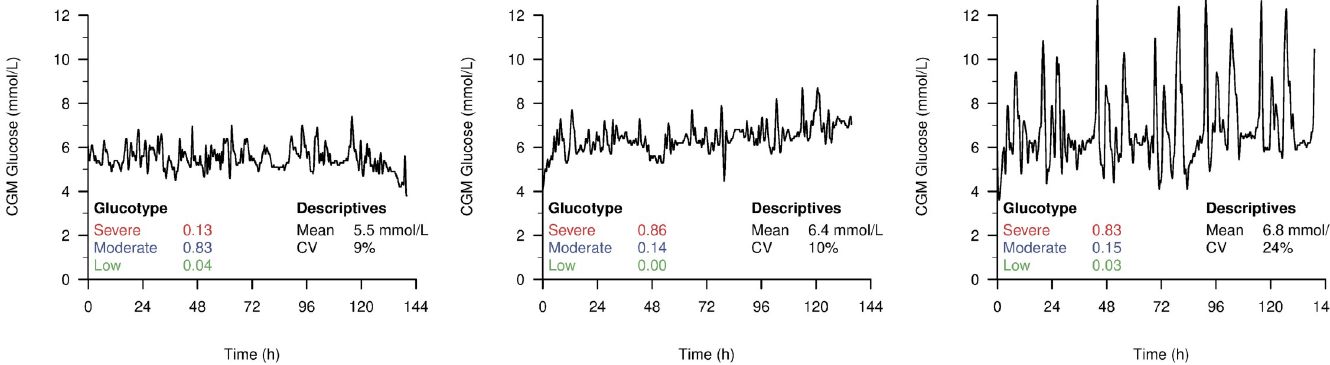
Fig 1. Example CGM profiles of participants in the PRE-D Trial with corresponding proportion of time spent in different glucotypes and conventional measures (mean and CV). CGM, continuous glucose monitoring; CV, coefficient of variation.